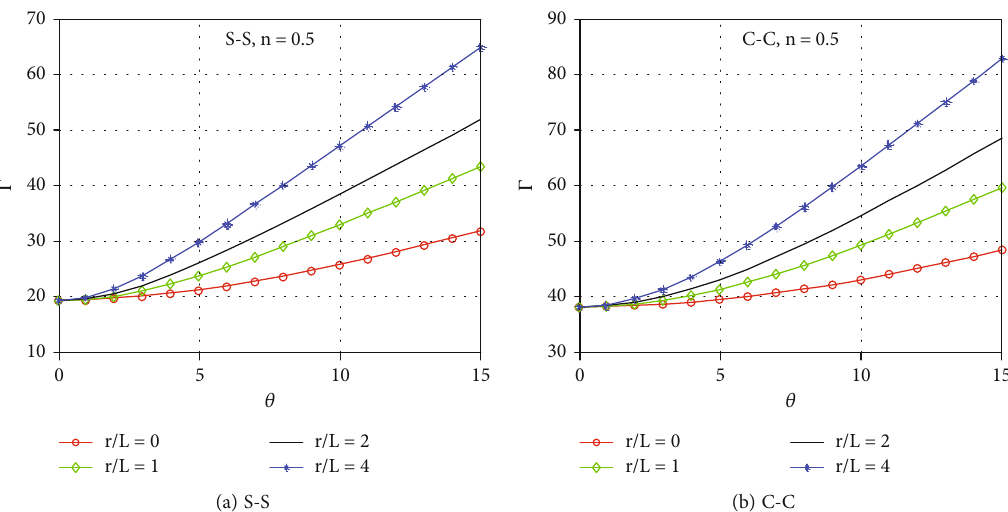
Figure 5: The subordination of the fi rst fundamental frequency of the piezoelectric FG beam on the ratio r / L and on the rotating speed ( n = 0 : 5